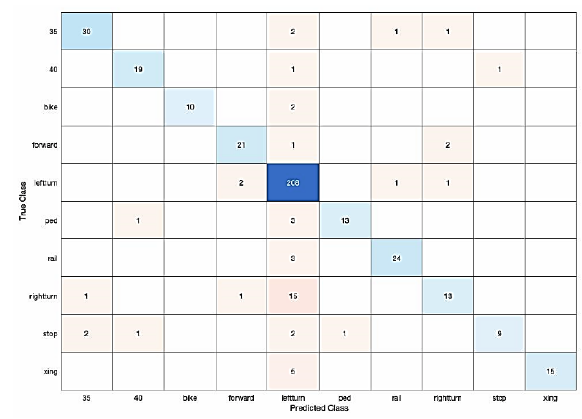
Figure 17. Confusion matrix for ROI_RESIZED detector + Colour CNN with top 10